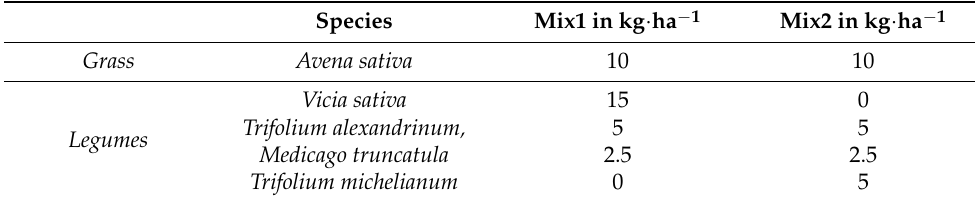
Table 1. Composition and sowing density of the two mixtures used for the test. Species Mix1 in kg · ha − 1 Mix2 in kg · ha − 1 Grass Avena sativa 10 10 Vicia sativa 15 0 Trifolium alexandrinum, Legumes Medicago truncatula Trifolium